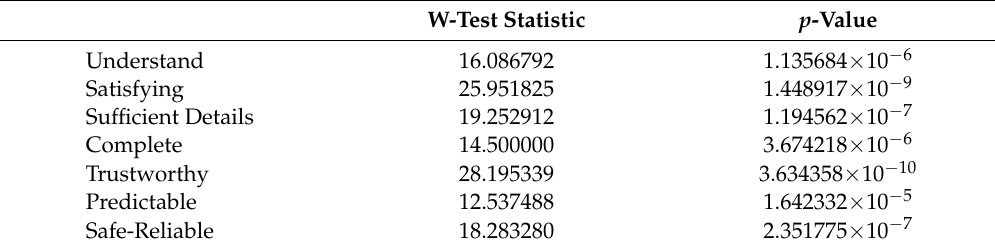
Table A7. Levene’s test results for “Why” explanations.